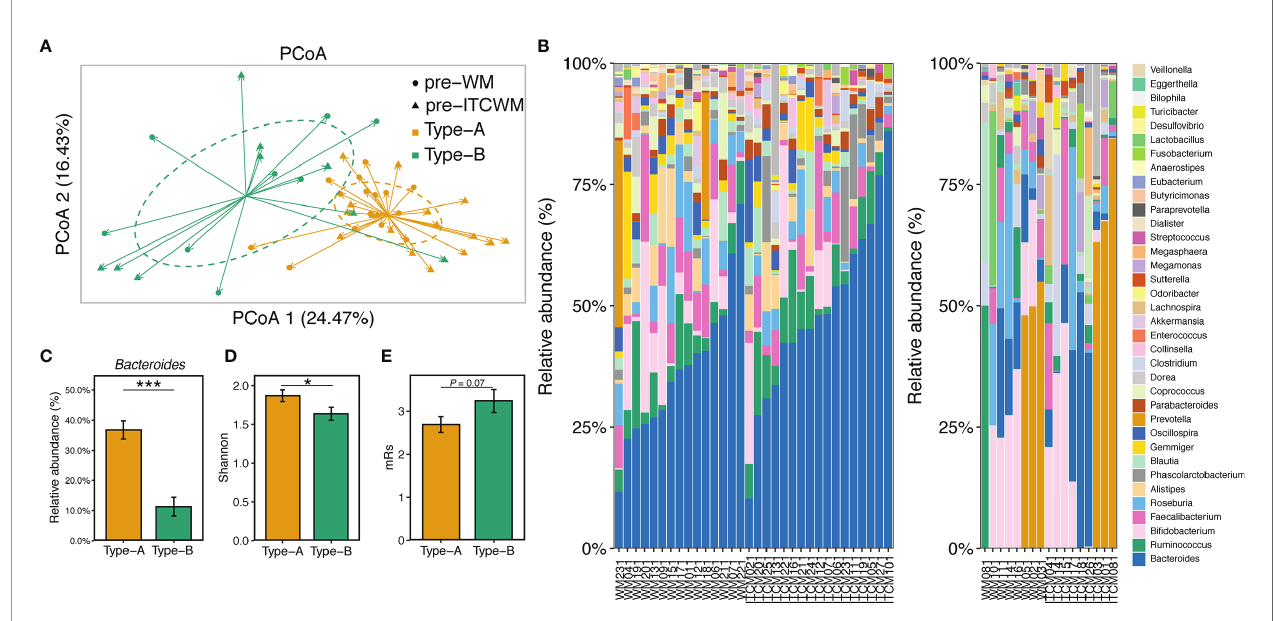
FIGURE 1 | Characterization of gut enterotypes in AIS samples. (A) PCoA based on Bray-Curtis distances at ASV level showed different taxonomic compositions between the two enterotypes. (B) Microbiota communities on the genus level. The samples in the left and right bar plots were ordered by the abundance of Bacteroides and Prevotella , respectively. (C) The abundance of Bacteroides in the two enterotypes. (D) Microbial diversity (Shannon index) of the two enterotypes. (E) mRs scores of the two enterotypes. The colors of bars represented the enterotypes. Red, Wm treatment; Blue, ITCM treatment. * p ≤ 0.05, *** p ≤